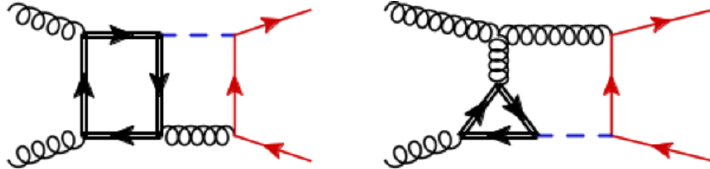
Figure 3 . Two-loop contributions involved in non-factorisable corrections. Loop particles depend on the details of the